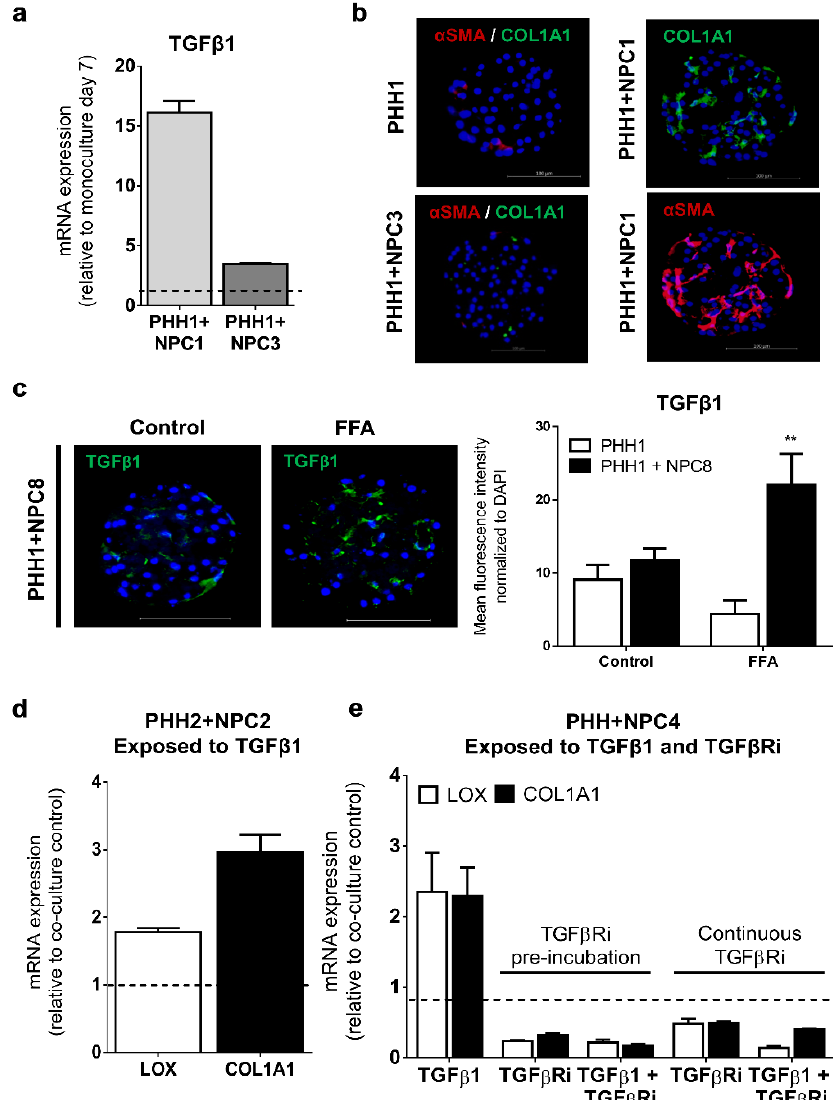
Figure 3. Reliance on TGF β 1 expression in NPCs to produce fibrogenic outcomes. NPCs from donor 1, as compared to donor 3 NPCs, when both combined with PHH1, had higher endogenous mRNA expression of TGF β 1 ( a ) which resulted in spontaneous protein expression of α SMA and COL1A1 ( b ). Additionally, TGF β 1 protein expression was typically higher in co-cultures (donor-dependent) and could be increased under FFA pressure ( c ). Exogenous TGF β 1 in co-culture spheroids from donor 2 induced COL1A1 and LOX mRNA expression ( d ) while in donor 4, similar induction was observed under TGF β 1 pressure, which was negated by TGF β Ri added before or during cultivation ( e ). ** p < 0.01.